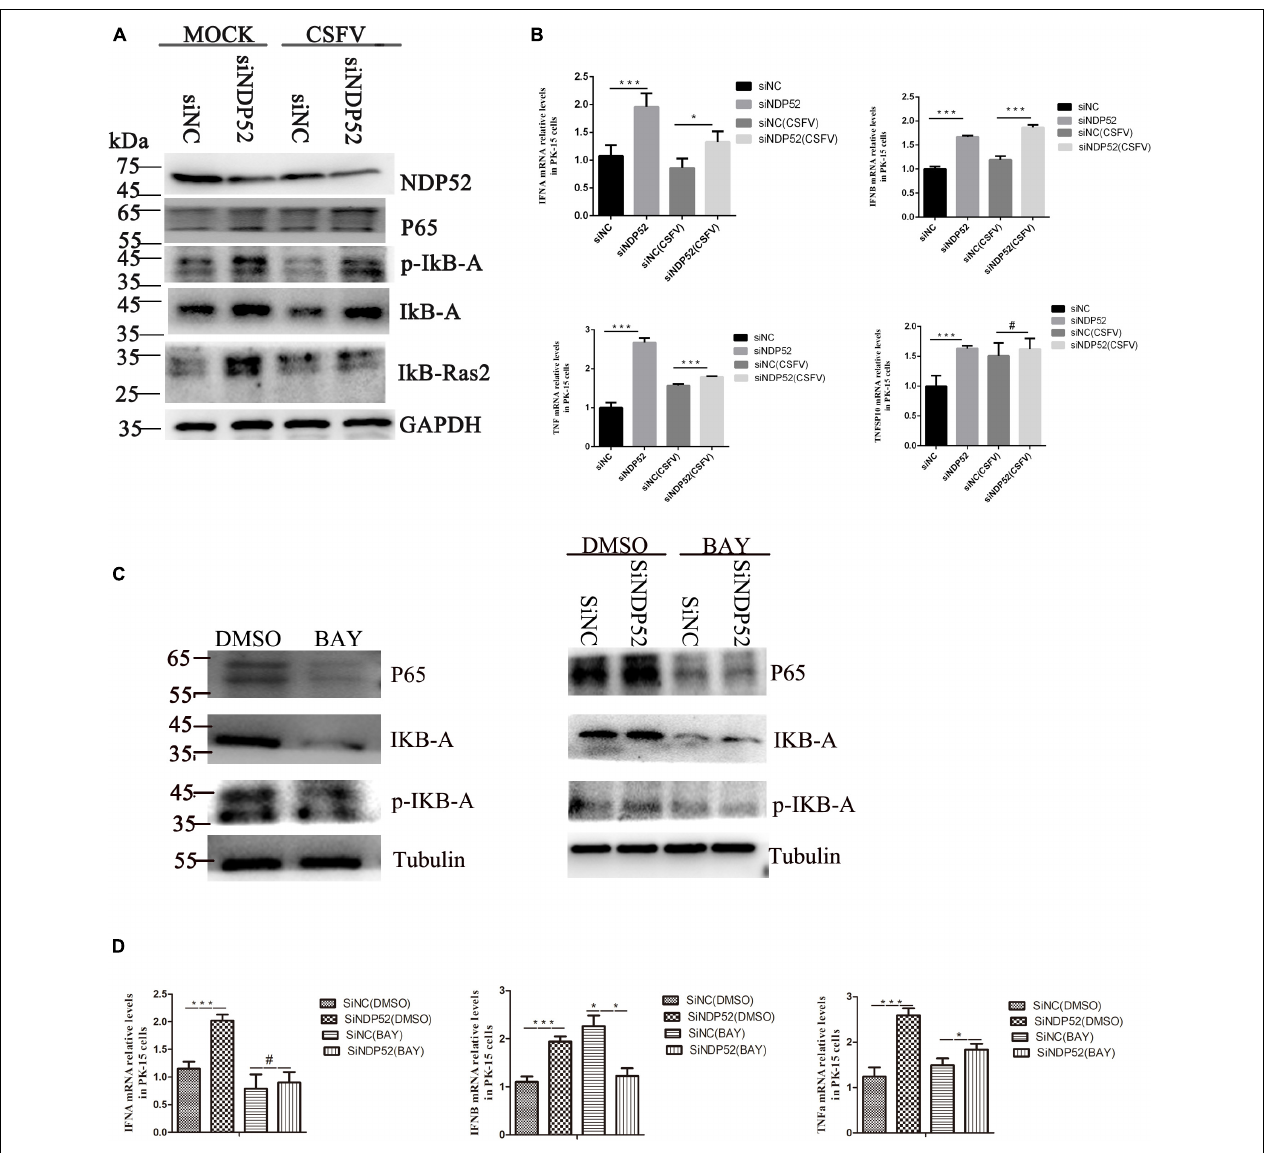
FIGURE 6 | Inhibition of NDP52 promotes innate immunity through the NF- κ B signaling pathway. (A) Inhibition of NDP52 has a positive effect on NF- κ B signaling pathway. PK-15 cells were mock-infected or infected with CSFV (MOI = 0.1) after transfection with siNDP52 for 24 h. NF- κ B signaling pathway proteins I κ B-A, P65, I κ B-Ras expression were analyzed by western blotting at 24 hpi. (B) PK-15 cells were treated as above. mRNA levels of the cytokines IFN- α , IFN- β , and TNF were detected by qRT-PCR. (C) PK-15 cells were co-transfection with scrambled or NDP52 siRNA with DMSO or BAY (5 µ M) for 24 h. NF- κ B signaling pathway proteins I κ B-A, P65, p-I κ B-A expression were analyzed by western blotting at 24 hpi. (D) PK-15 cells were treated as (C) , mRNA levels of the cytokines IFN- α , IFN- β , and TNF were detected by qRT-PCR. The data represent mean ± SD in three independent experiments. Data were tested by one-way ANOVA with post hoc LSD (L). ∗ P < 0.05; ∗∗ P < 0.01; ∗∗∗ P < 0.001; # P >